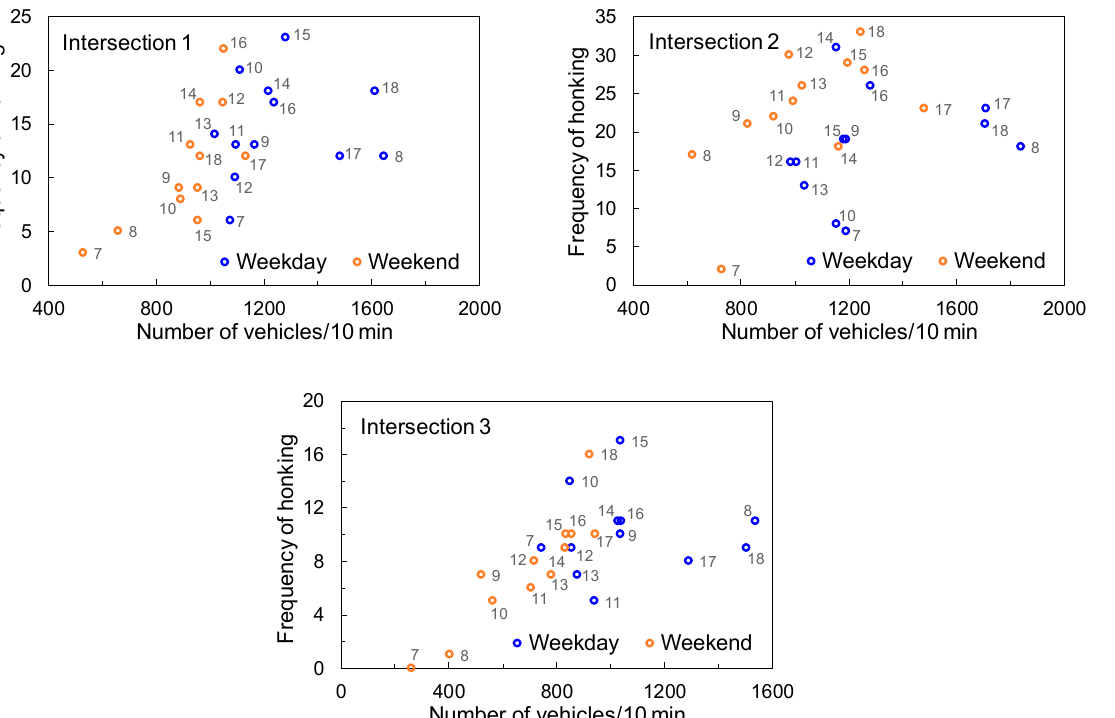
Figure 4. Relationship between the total traffic volume and frequency of horn use during the recorded 10 min in each time zone.